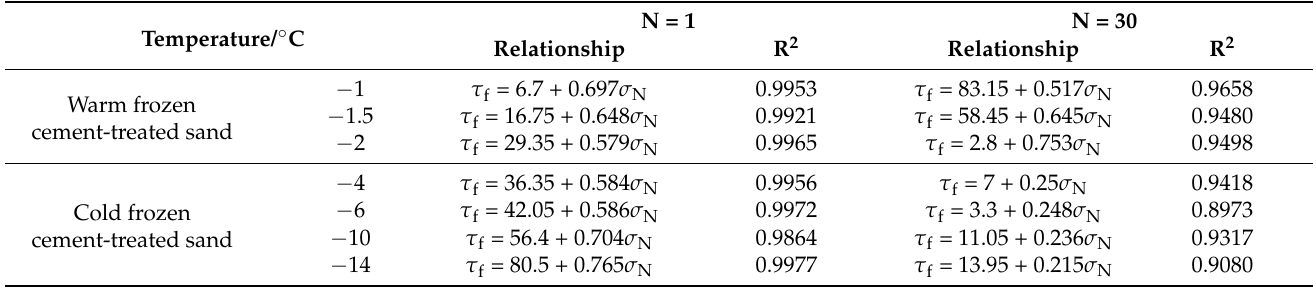
Table 4. Variation of the relationship between τ f and σ N for N = 1 and N = 30 at different temperatures.